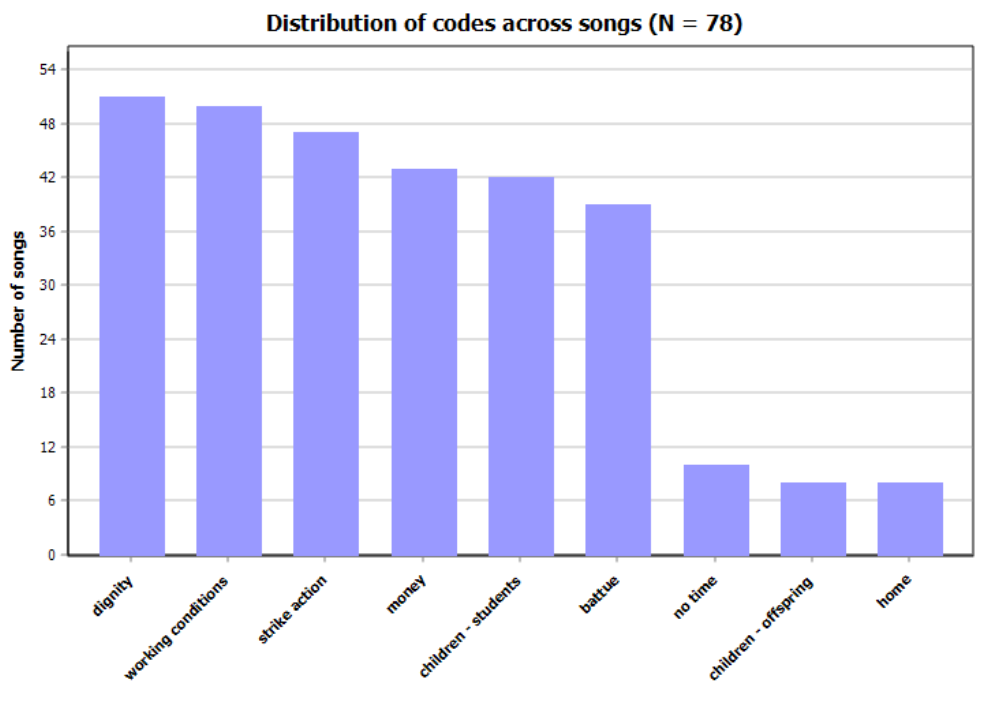
Figure 2. Themes identified in the songs (author's own